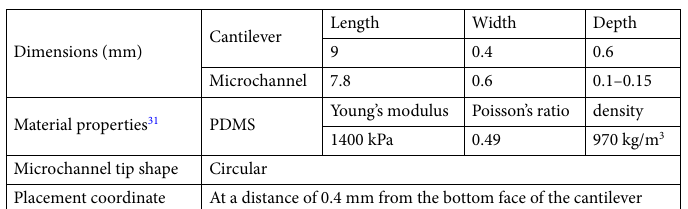
At a distance of 0.4 mm from the bottom face of the Table 1. The values of parameters and dimensions for cantilever fabrication.